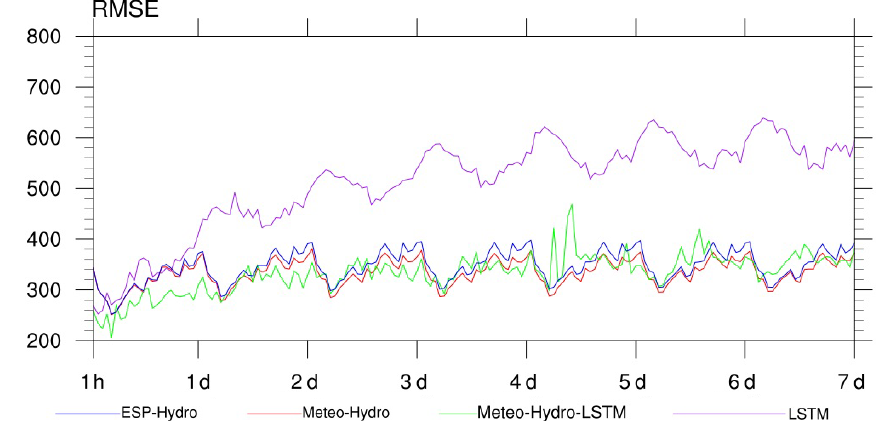
Figure 9. The RMSE (m 3 /s) for the hourly streamflow hindcasts from four forecasting approaches. The green line represents the Meteo- Hydro-LSTM forecast, the red line represents the Meteo-Hydro forecast, the blue line represent the ESP-Hydro forecast and the purple line represents the LSTM forecast based on historical streamflow observations alone.